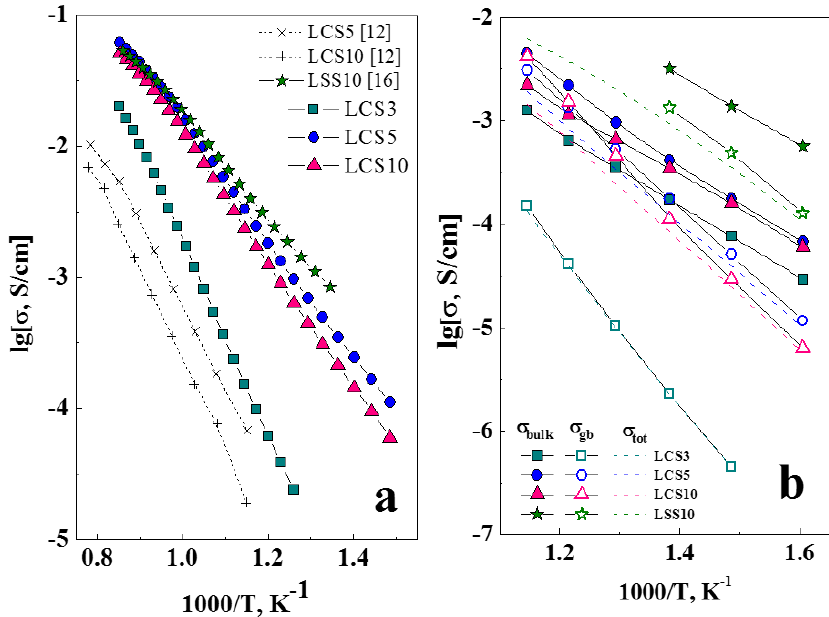
Figure 7. Temperature dependencies of electrical conductivities for LCS3, LCS5, LCS10 ceramics under wet air ( p H 2 О = 4.5 kPa) by four ‐ probe DC method ( a ), and by two ‐ probe impedance method ( b ).